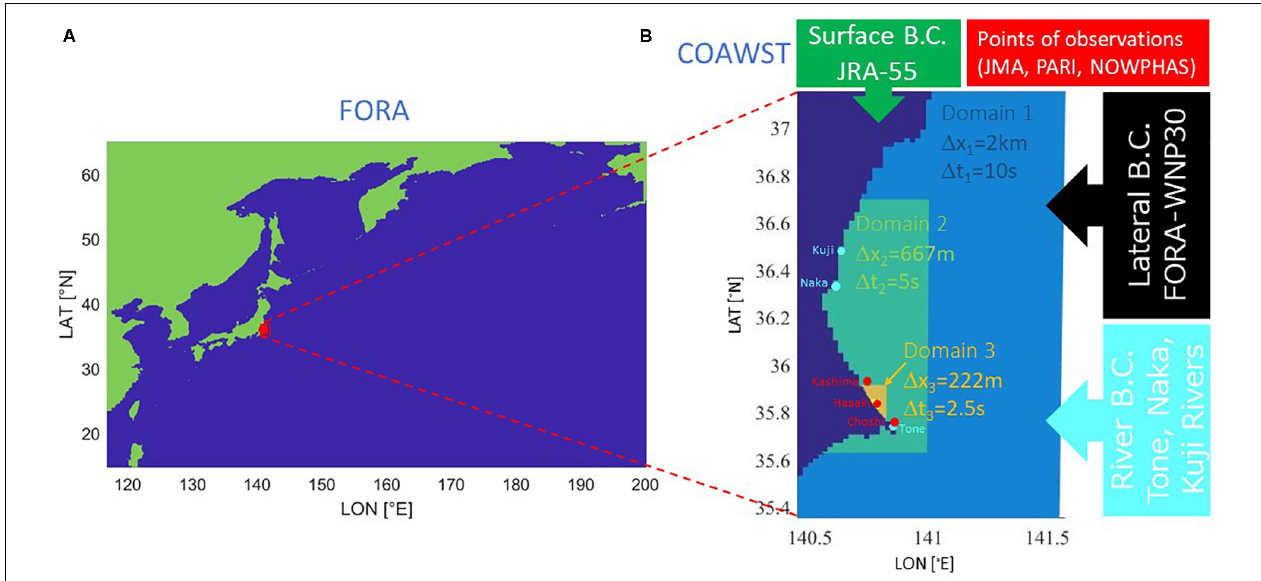
FIGURE 1 | (A) Geographic position of FORA domain and COAWST domain 1 (red dot) on the Ibaraki Coast; (B) Schematic representation of COAWST model setup (resolutions at domain 1: 2 km; domain 2: 667 m; domain 3: 222 m), and marked locations of river mouths (cyan dots) and observation points (red dots).